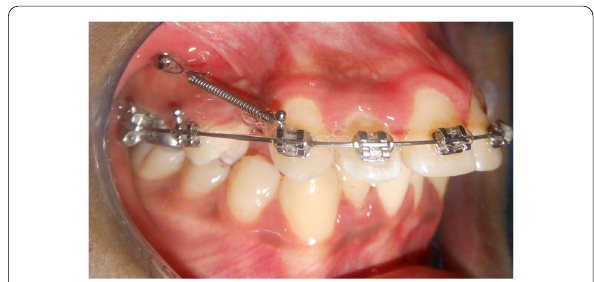
Fig. 1 Miniscrew for maxillary canine retraction using NiTi coil